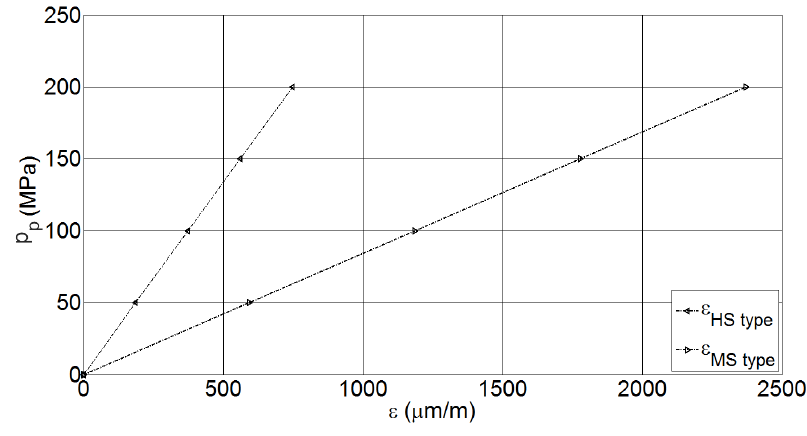
Figure 13. Comparison between the HS and MS deformations: applied pressure vs. strain.